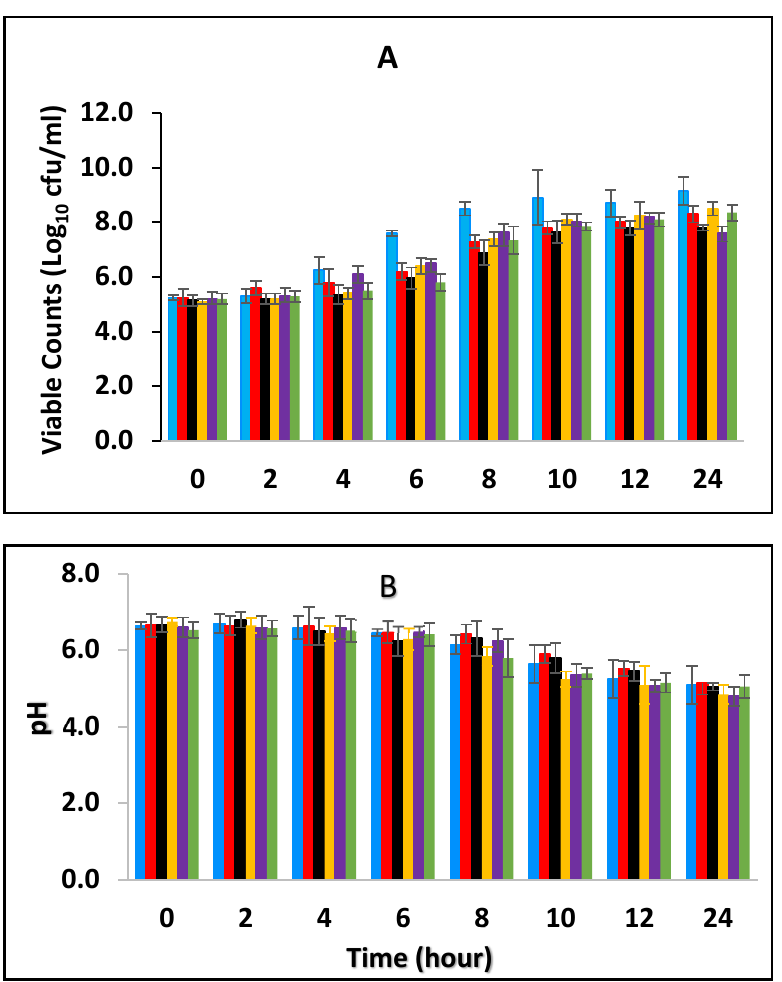
Figure 1. Growth of E. fergusonii ( A ) and change in pH ( B ) in fermenting milk in the presence of essential oils of black pepper (BPE) and cinnamon extracts (CE) at different concentrations at 25 °C for 24 h. Concentrations are in % ( w / v ), values are the mean of three individual replicates (means ± SD). Control [ ]; 0.5% BPE alone [ ◼ ]; 0.1875% CE + 0.125% BPE [ ◼ ]; 0.125% CE + 0.25% BPE [ ◼ ]; 0.0625% CE + 0.375% BPE [ ◼ ]; 0.25% CE alone [ ◼ ].